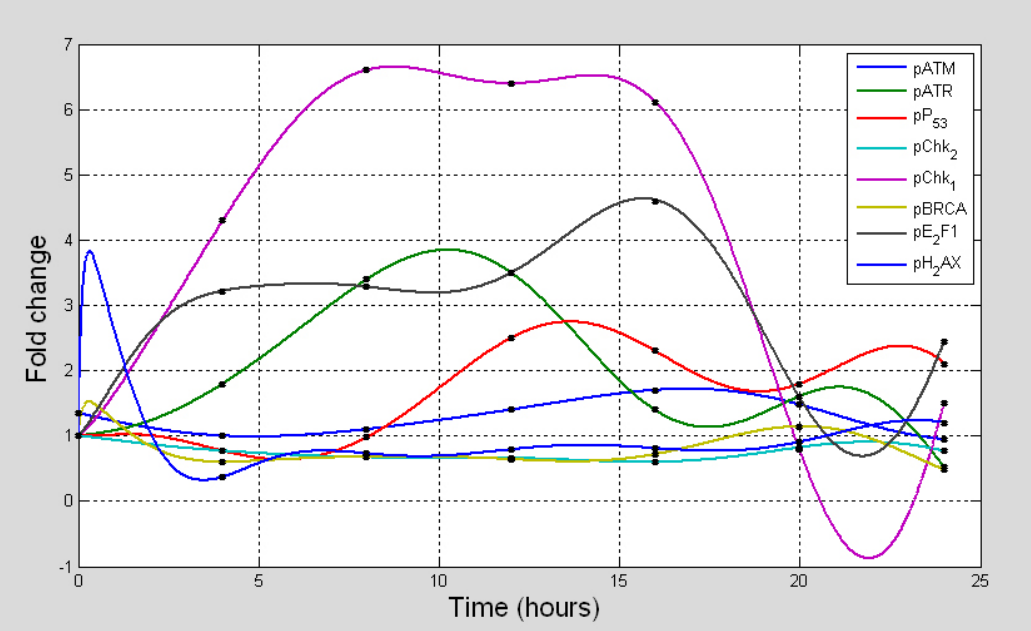
Figure 16. Simulated system dynamics of the DDR pathway that are most consistent with the historical time series measure- ments at (0.4 µ M) dose-intensities of doxorubicin with KU treatment.